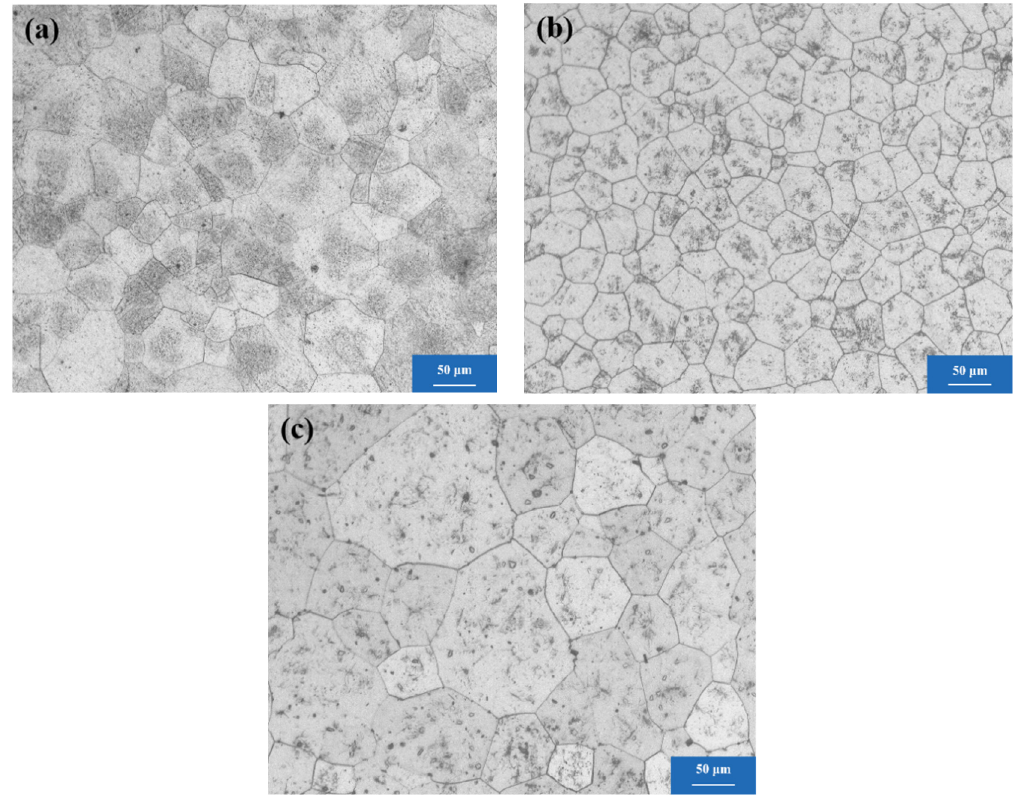
Figure 1. OM images of the T6-treated alloys. ( a ) GZ31K, ( b ) GZ61K, ( c ) GZ91K.